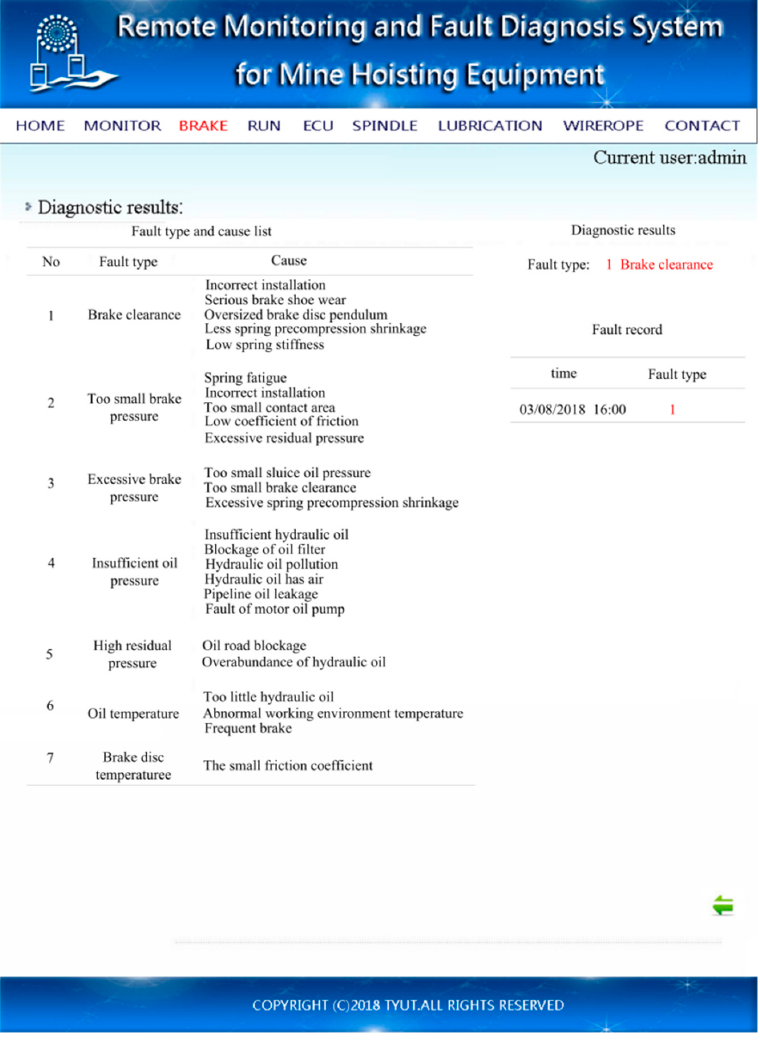
Figure 9. Interface of fault release.